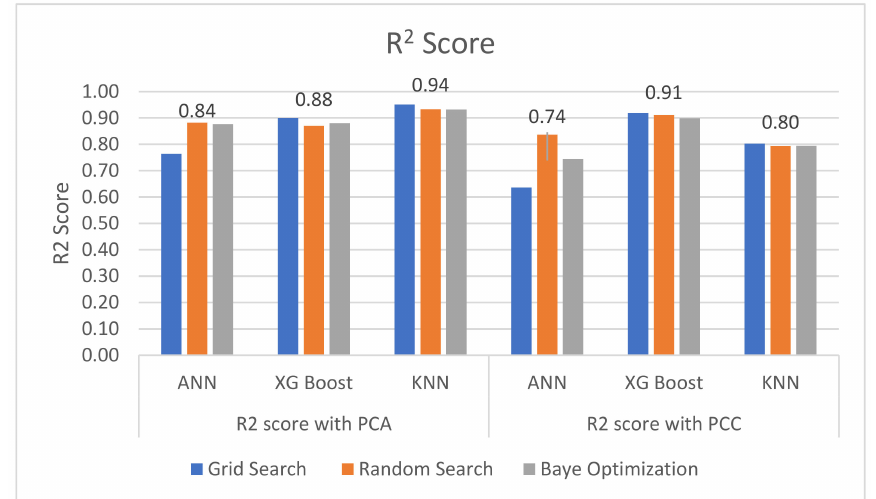
Figure 16. R 2 Scores Obtained from Each Model with PCA and PCC.